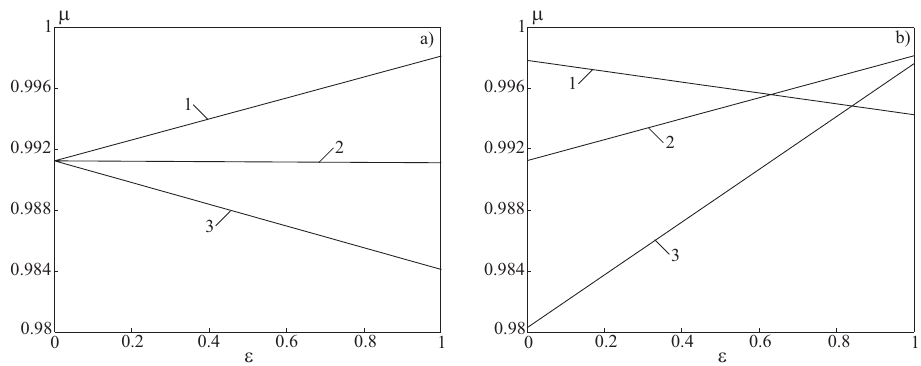
Figure 23. Dependance of rate coefficient on nozzle linear movement for α = 4.6 ◦ ( a ) and k G = 0.1 ( b ).